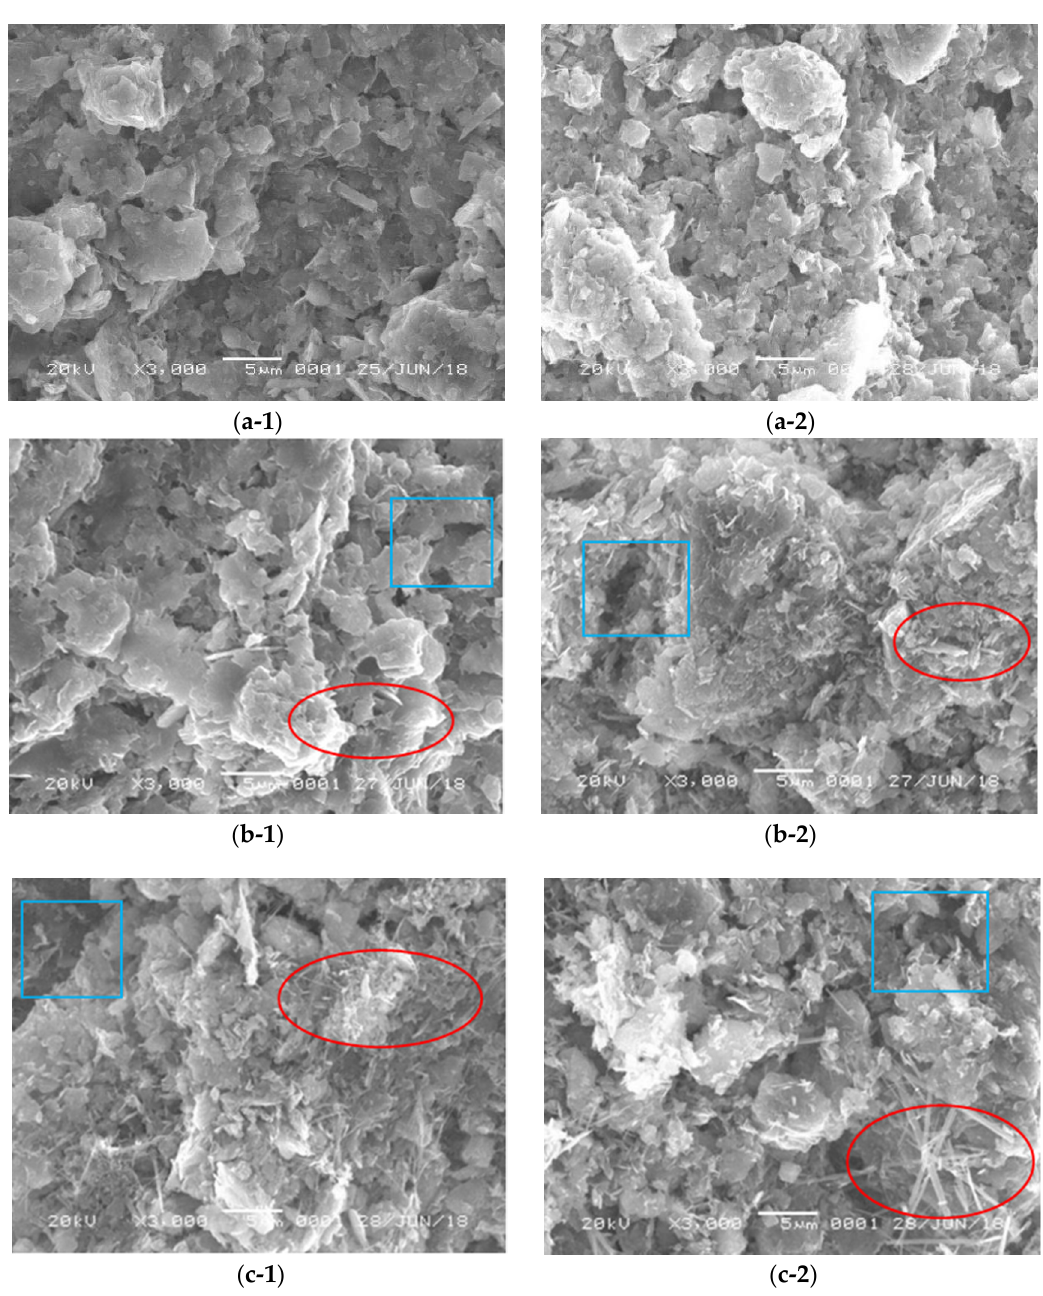
Figure 10. SEM image. ( a-1 ) OCC; ( a-2 ) PCC; ( b-1 ) OCC under 3 freeze–thaw cycles; ( b-2 ) PCC under 3 freeze–thaw cycles; ( c-1 ) OCC under 15 freeze–thaw cycles; ( c-2 ) PCC under 15 freeze–thaw cycles.